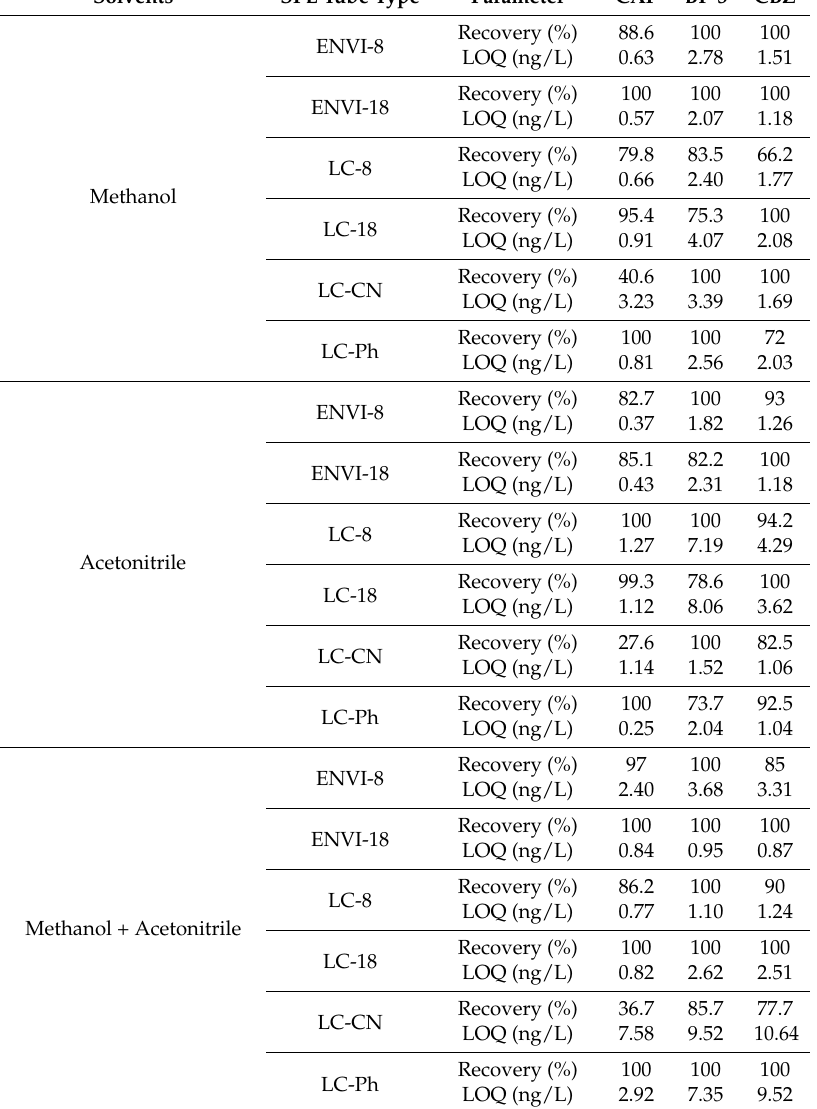
Table 5. Recovery and limit of quantification (LOQ) for various combinations of SPE tube types and solvents.